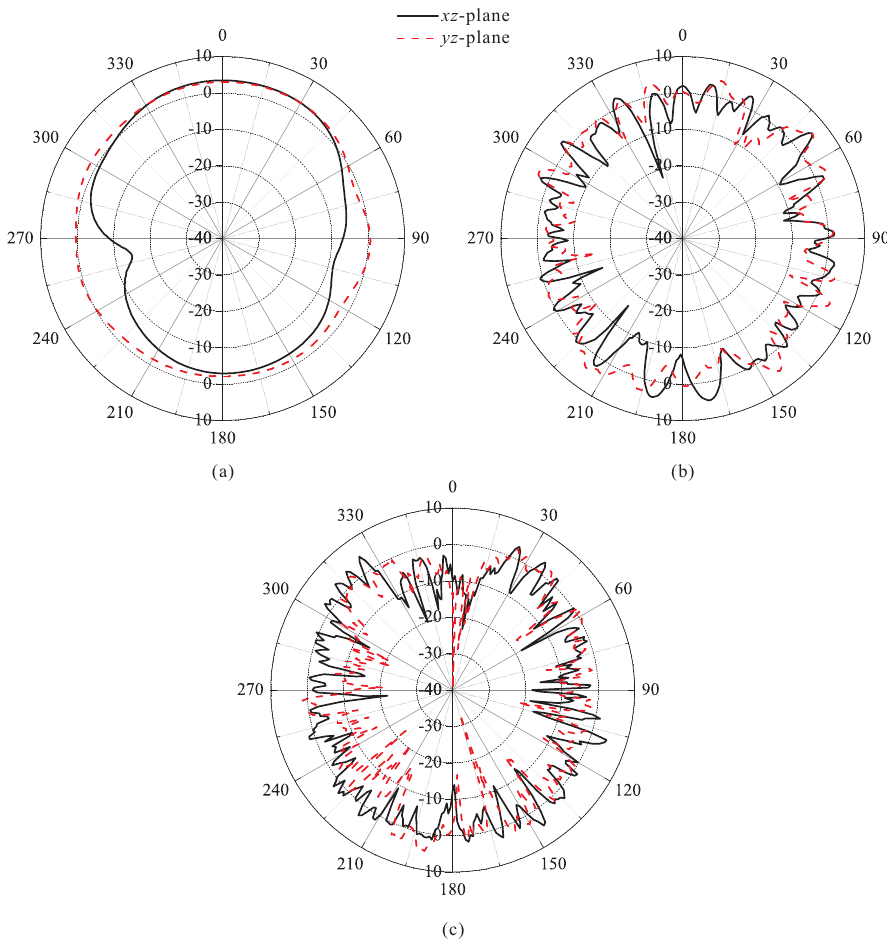
Figure 10. Measured radiation patterns of the proposed antenna at ( a ) 0.5 GHz; ( b ) 8 GHz; ( c ) 15 GHz.